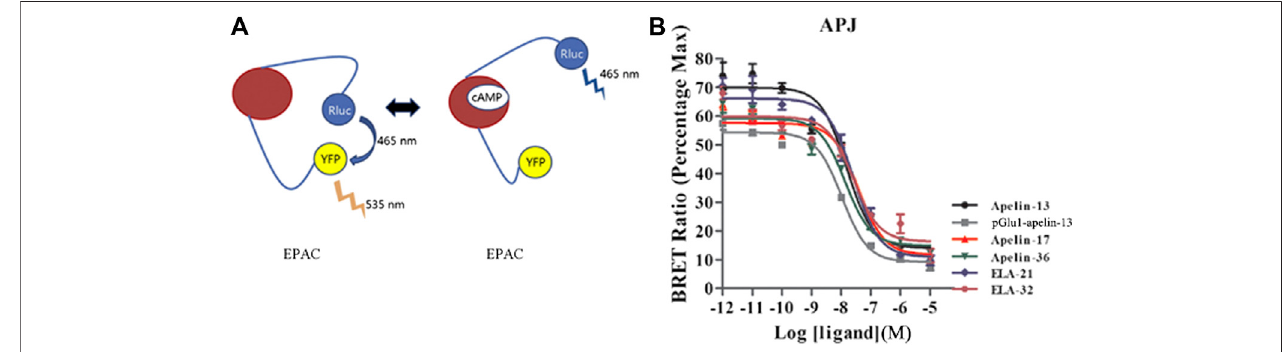
FIGURE 1 | Intracellular cAMP production induced by the six agonists. (A) A schematic diagram of YFP-cAMP-Rluc fusion expression vector. (B) In HEK293 cells stably expressing APJ, the cAMP dose-response curve was measured at 20 min after stimulation with six peptide. p < 0.05 was considered as statistically signi fi cant. Data represent mean ± SEM from four independent experiments ( Supplementary Table S1